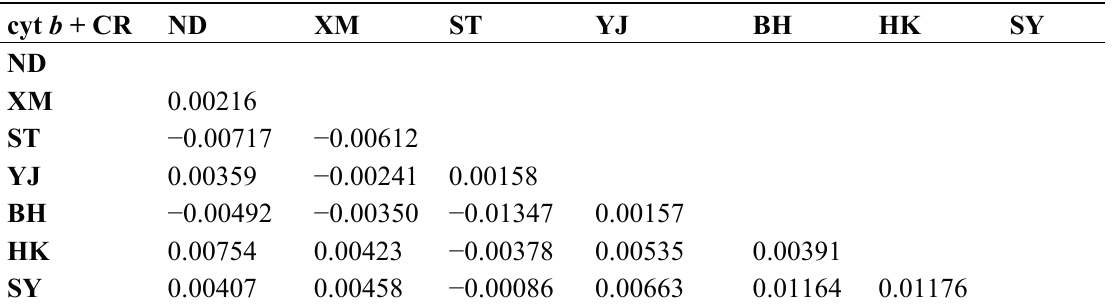
Table 2. Matrix of pairwise of F in Cirrhimuraena chinensis .